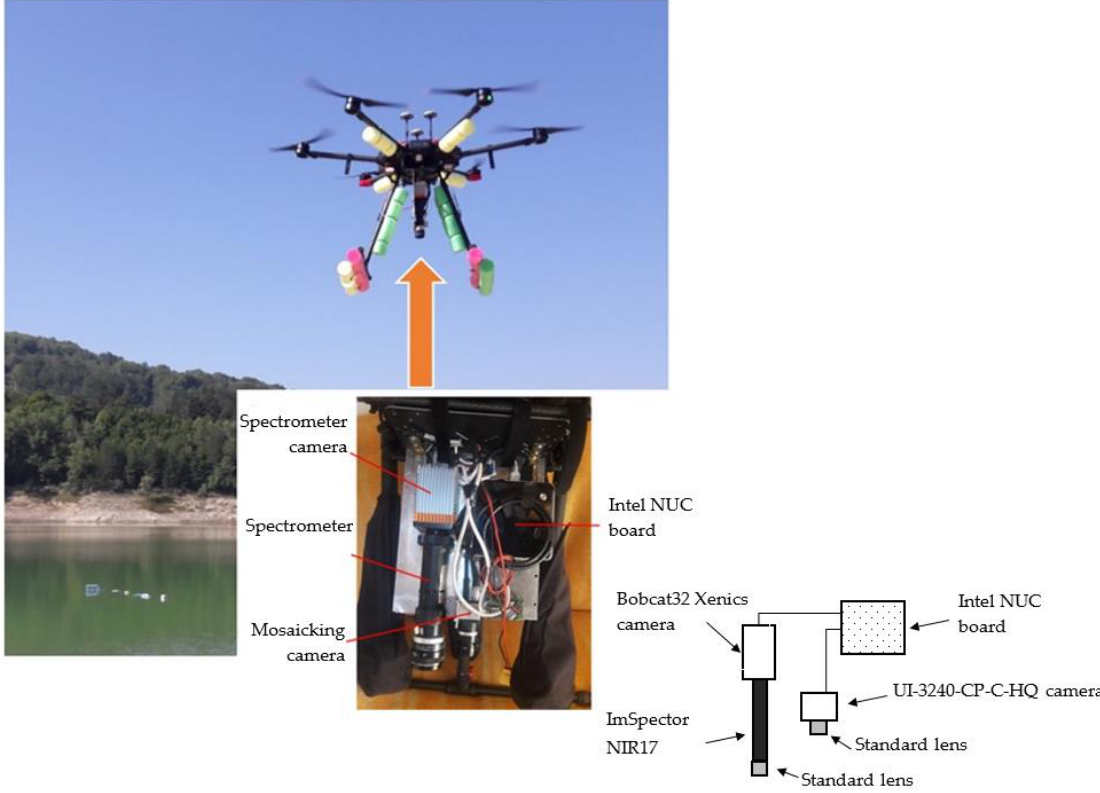
Figure 3. Drone employed for the measurement campaigns and details of the instrumentation onboard. A linear spectrometer ImSpector NIR17 OEM (Specim, Finland) is coupled with a SWIR camera (Bobcat 32 from Xenics, Belgium) of 256 × 320 pixel resolution (50